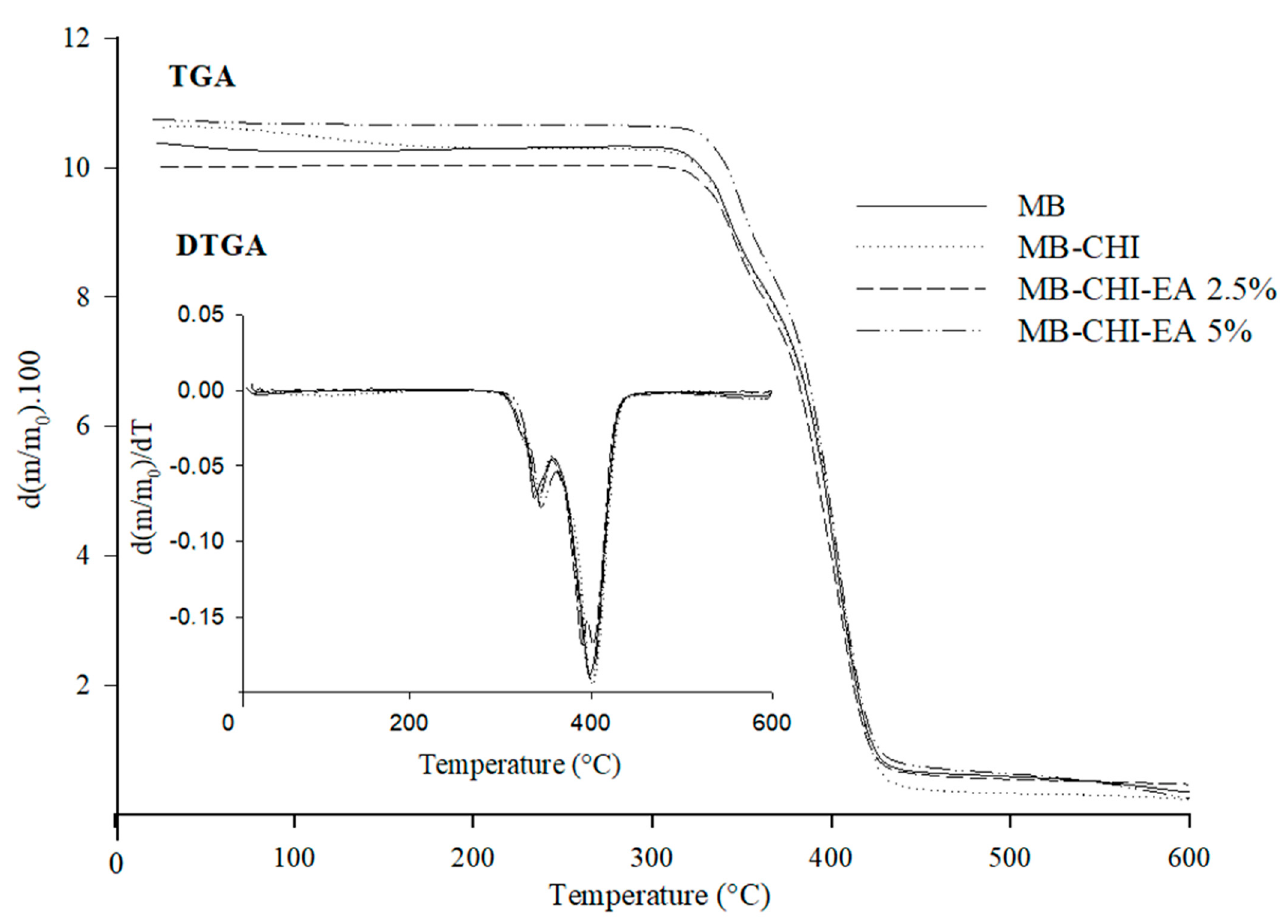
Figure 4. TGA and DTGA curves obtained for biopolymers and active coating biopolymers.